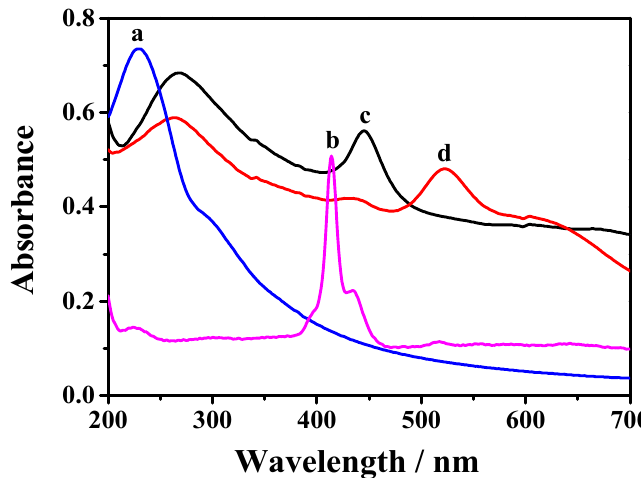
Figure 1. UV–vis spectra of graphite oxide (GO) suspension (a); TCPP (b); TCPP–Gr suspension (c); and TCPP–Gr/AuNPs suspension (d).